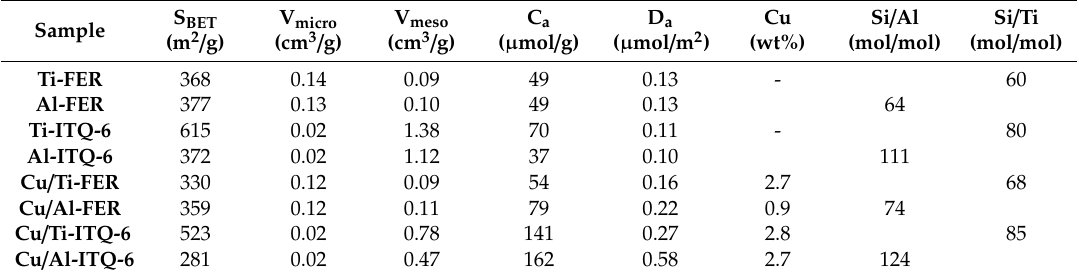
Table 1. Textural parameters, surface acidity, copper content, as well as molar Si / Al and Si / Ti ratios in zeolitic samples.